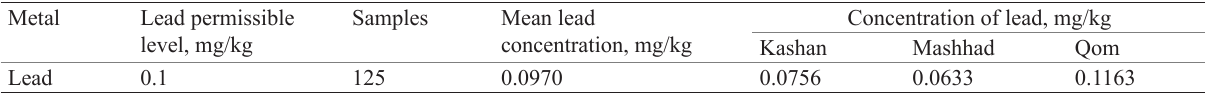
Table 2 Concentration of lead in eggs from different cities ( P ≤ 0.05) mg/kgSamplesLead permissible mg/kgMetal level,